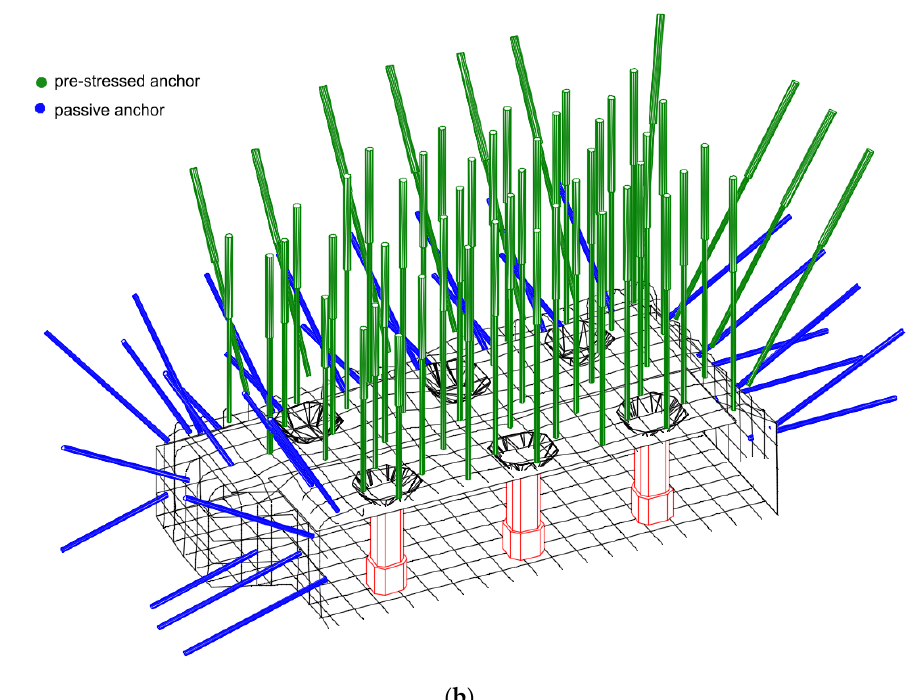
Figure 5. Schematic of the installation of the anchors in the roof and the walls of Room 2 (green color indicate pre-stressed anchors and blue color indicate passive anchors); ( a ) the layout and annotation of measuring anchors ( b ) the axonometric view of the eastern half of the room.